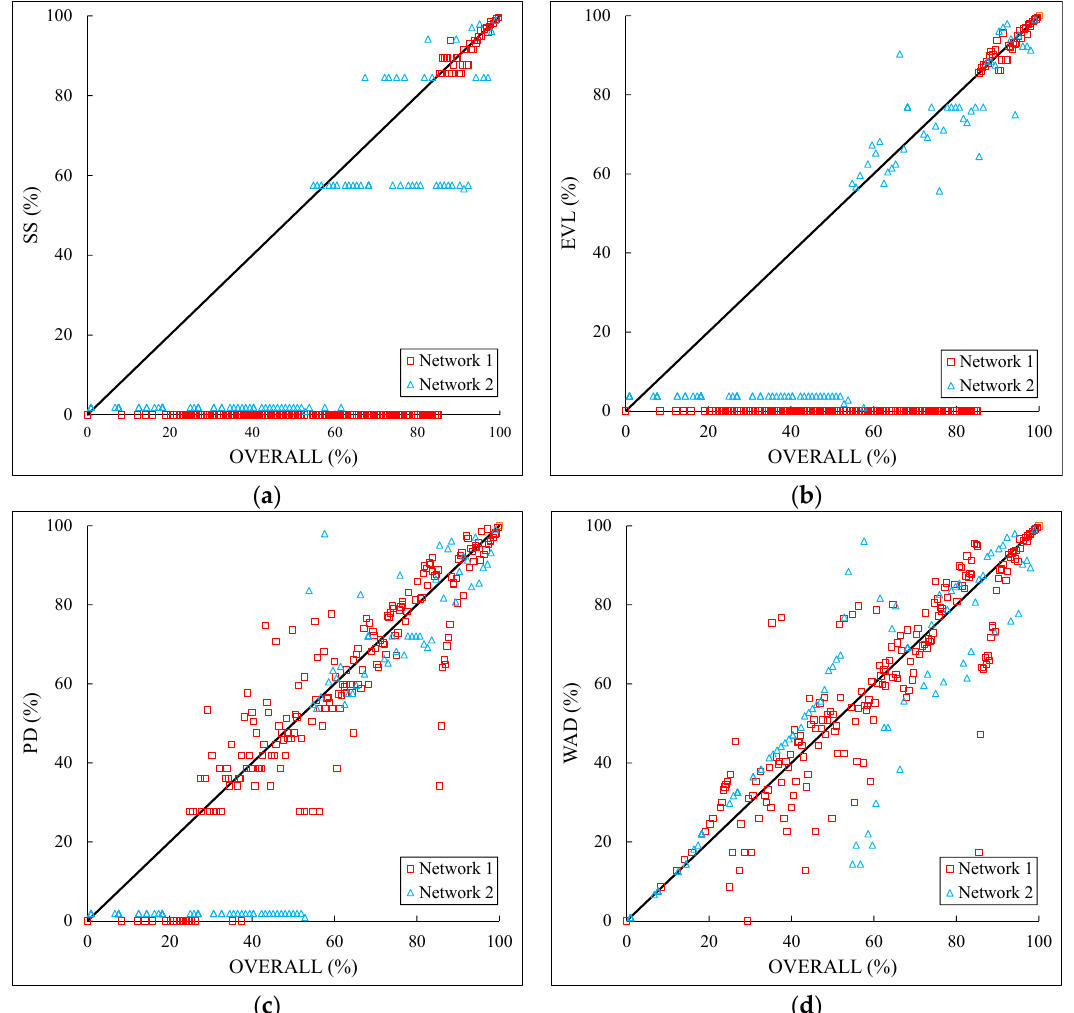
Figure 8. Comparison of the OVERALL criticality with ( a ) supply shortage ( SS ), ( b ) economic value loss ( EVL ), ( c ) pressure decline ( PD ), and ( d ) water age degradation ( WAD ) for Networks 1 and 2.